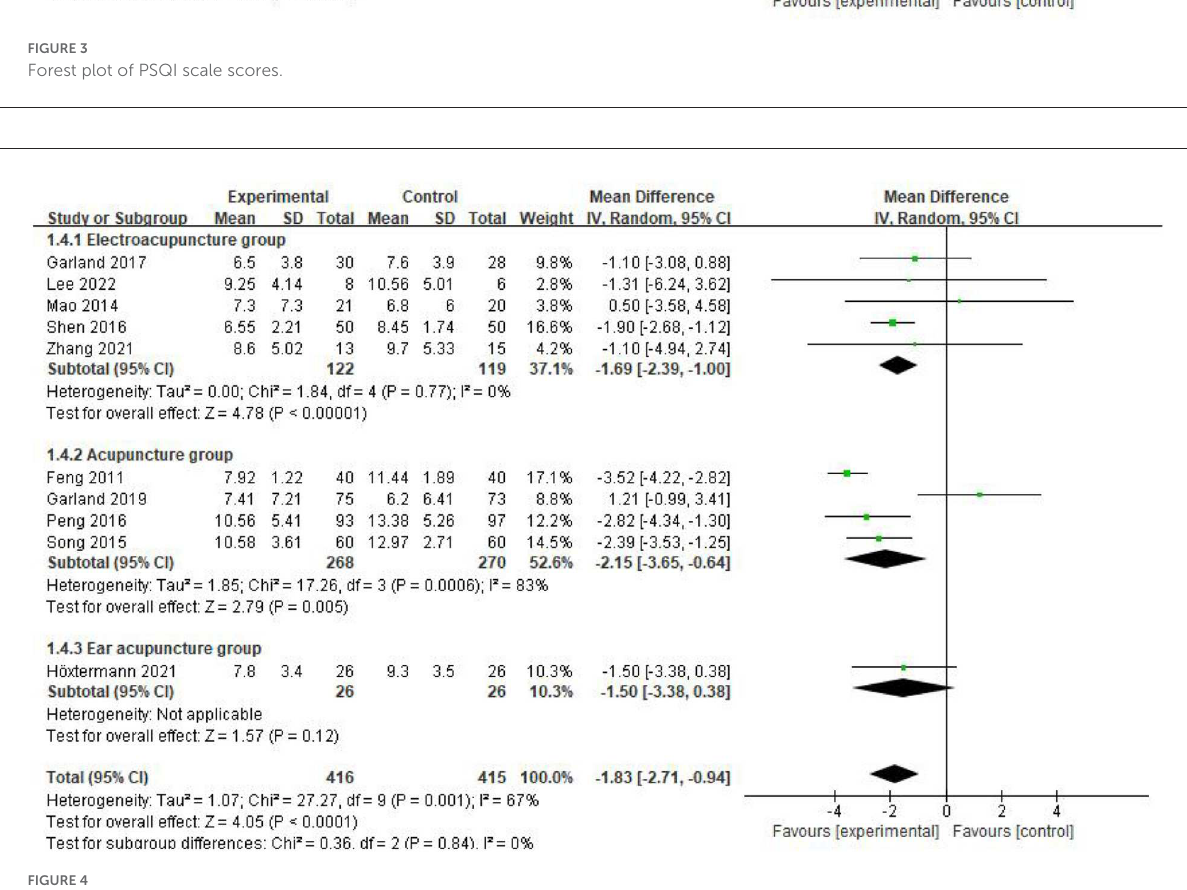
FIGURE4 Subgroup analysis of PSQI